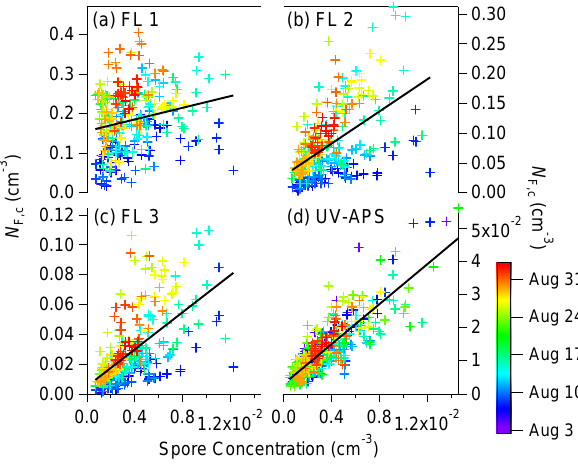
Figure 6. Demonstrated relationship of N F , C determined by the real-time instruments vs. a sum of a subset of spores collected by the Sporewatch impactor. Spores here include ascospores, basid- iospores, and Ganoderma spp., which make up approx. 88% of total spore concentration (remaining percentage being Cladospo- rium spp.). Crosses represent 2h measurement points, colored by sampling date. Black lines represent unweighted linear fits, with coefficients as follows: (a) FL1 ( m = 7.67, R 2 = 0.052), (b) FL2 ( m = 14.03, R 2 = 0.290), (c) FL3 ( m = 6.47, R 2 = 0.380), and (d) UV-APS ( m = 3.00, R 2 = 0.710). All vertical axes have different